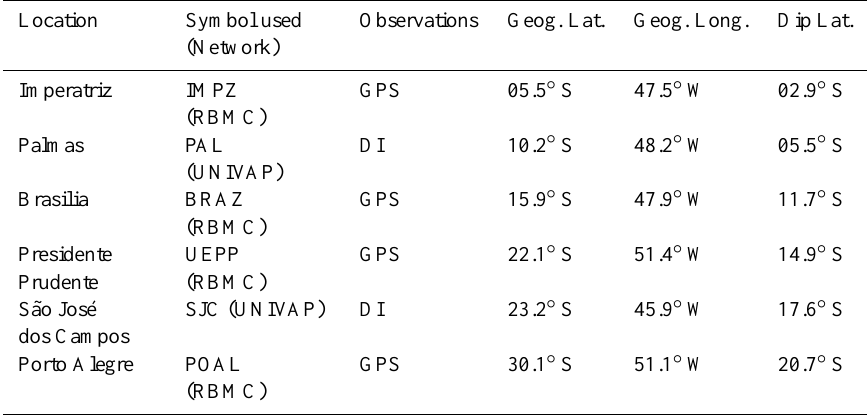
Table 1. Details of the global positioning system (GPS) and digital ionosonde (DI) sites in Brazil used in the present study. For all the stations LT=UT − 3h.